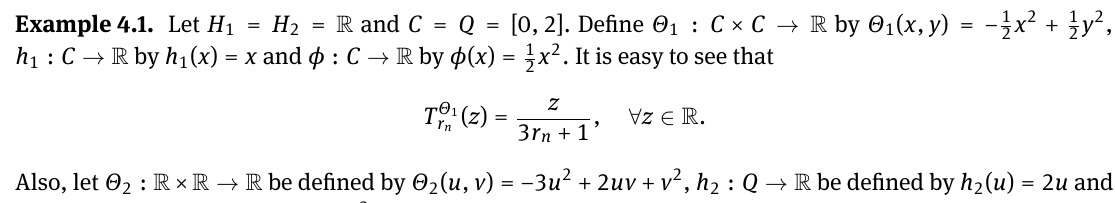
Figure 1: x 1 = 0.2375 , Left: accuracy against number of iterations; Right: errors against numbers of